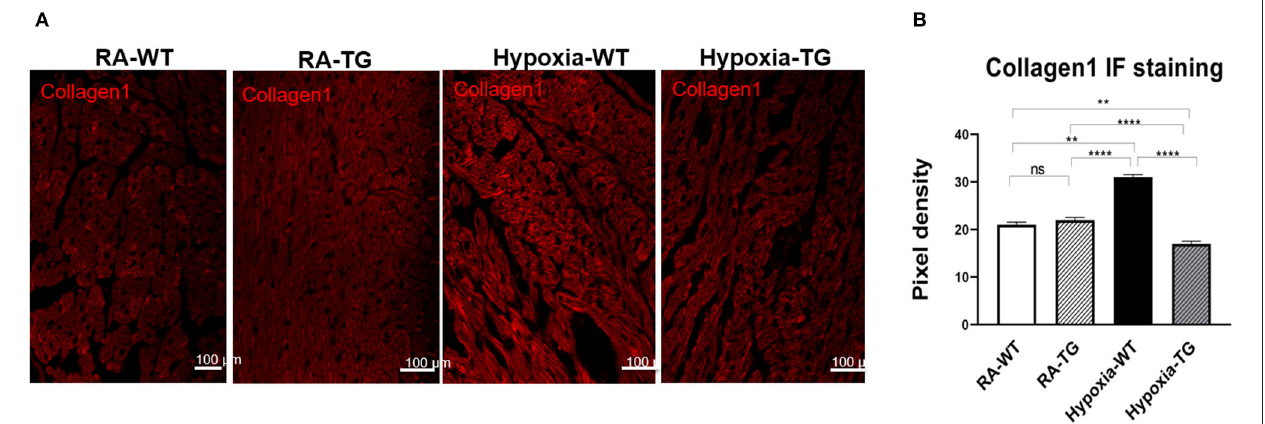
FIGURE 3 | Immunohistochemistry for Collagen 1. Right ventricular tissue from adult wild-type mice WT and EC-SOD transgenic mice (TG), which were exposed to FiO 2 10% hypoxia for 21 days (WT) and a room air control group (RA) were treated with Cy3 stain to assess for levels of Collagen 1 (A) . The images were analyzed using Fiji image processing software to measure pixel density (B) . All experiments n = 5. Data represents mean ± SEM. * P < 0.05, ** P < 0.01, *** P < 0.001, **** P < 0.0001.